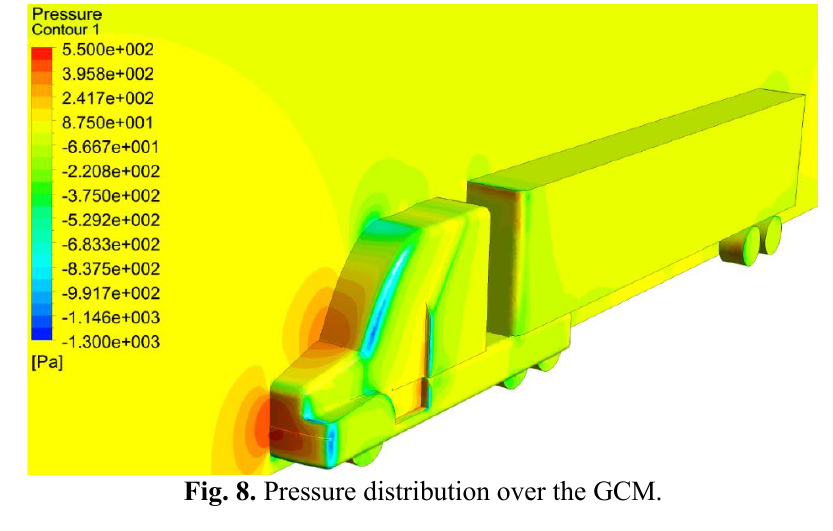
Fig. 8. Pressure distribution over the GCM.